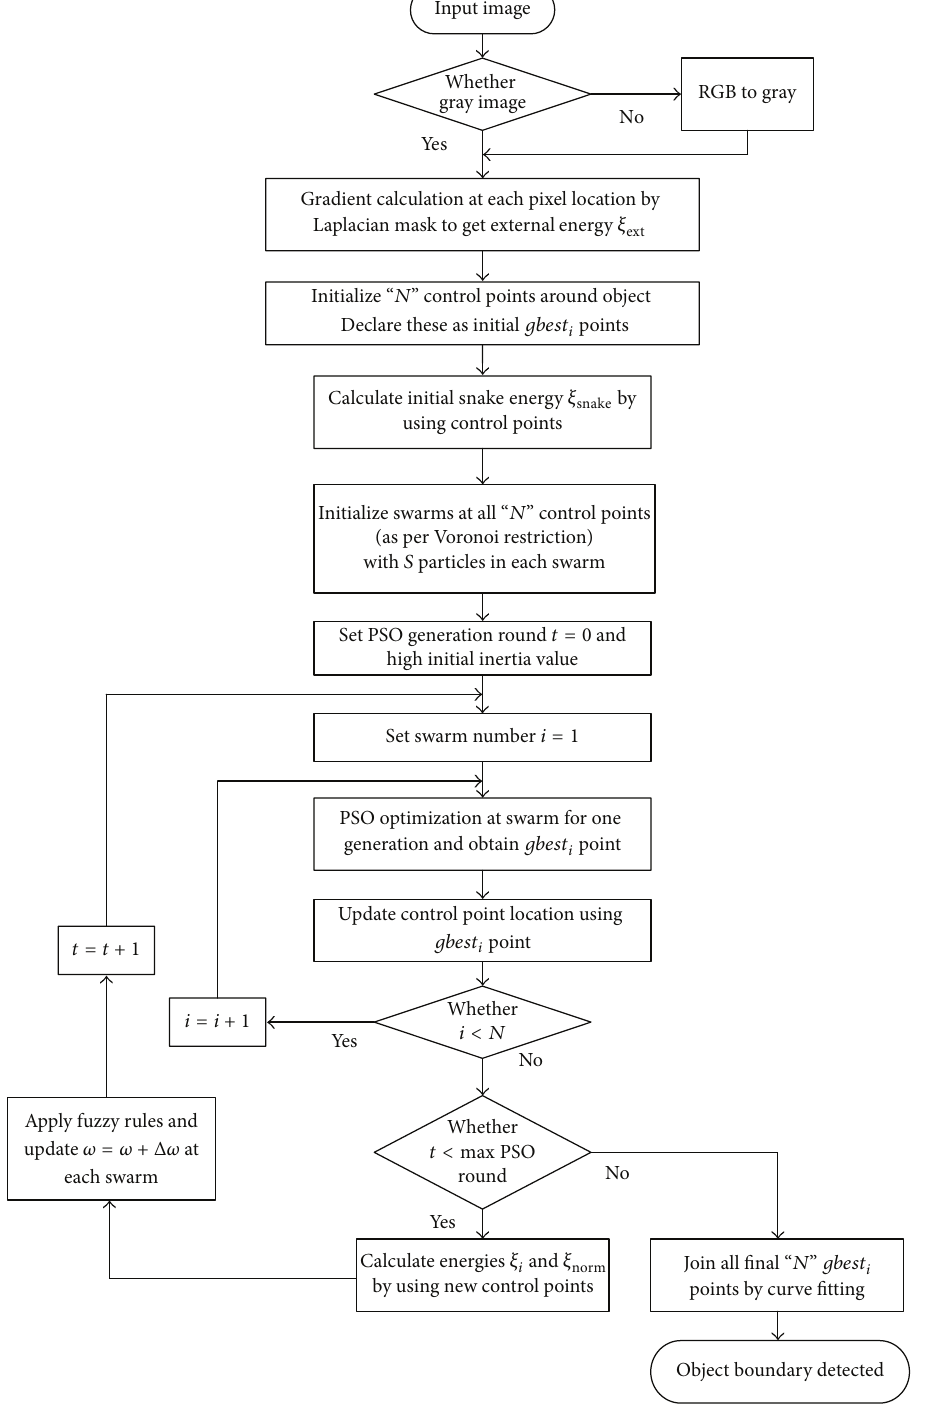
Figure 5: Flow chart of proposed active contour model by using multiswarm PSO with fuzzy adaptive inertia factor.